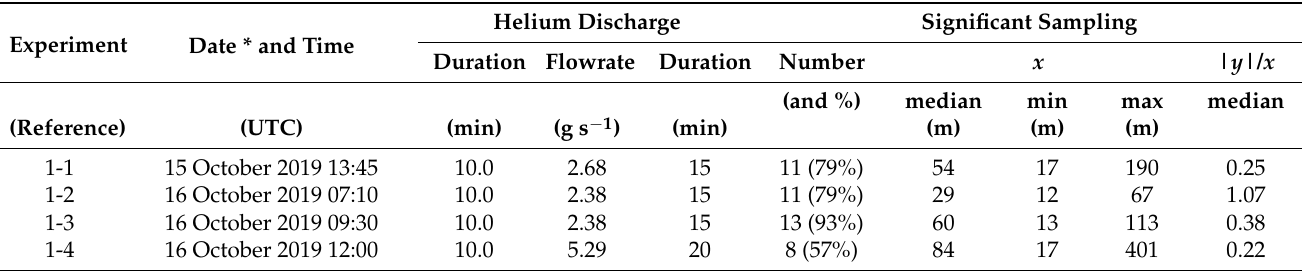
perpendicular to the wind